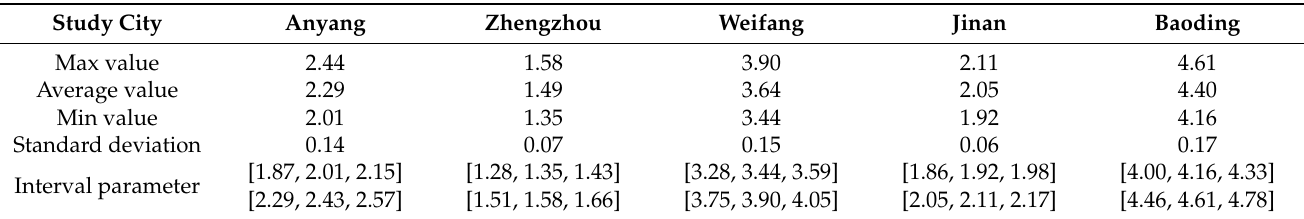
Table 7. Fuzzy interval parameters and statistical description of summer corn planting areas (10 5 hectares) in five studied